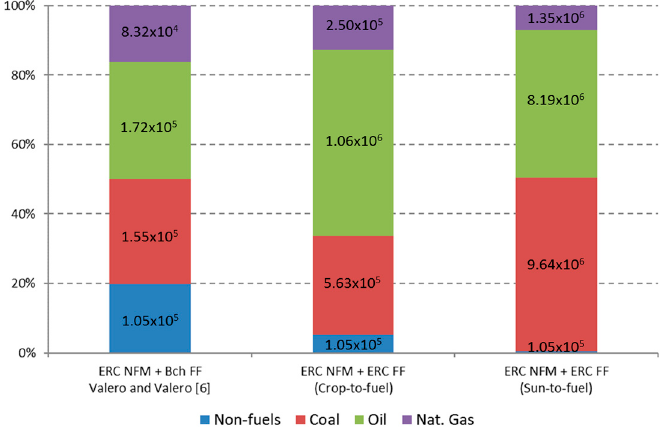
Figure 8. Comparison of methods for world’s mineral capital depletion 1900 to 2008 (Value in Mtoe). ERC: Exergy replacement cost, NFM: non-fuel minerals, Bch: chemical exergy, FF: fossil fuels.